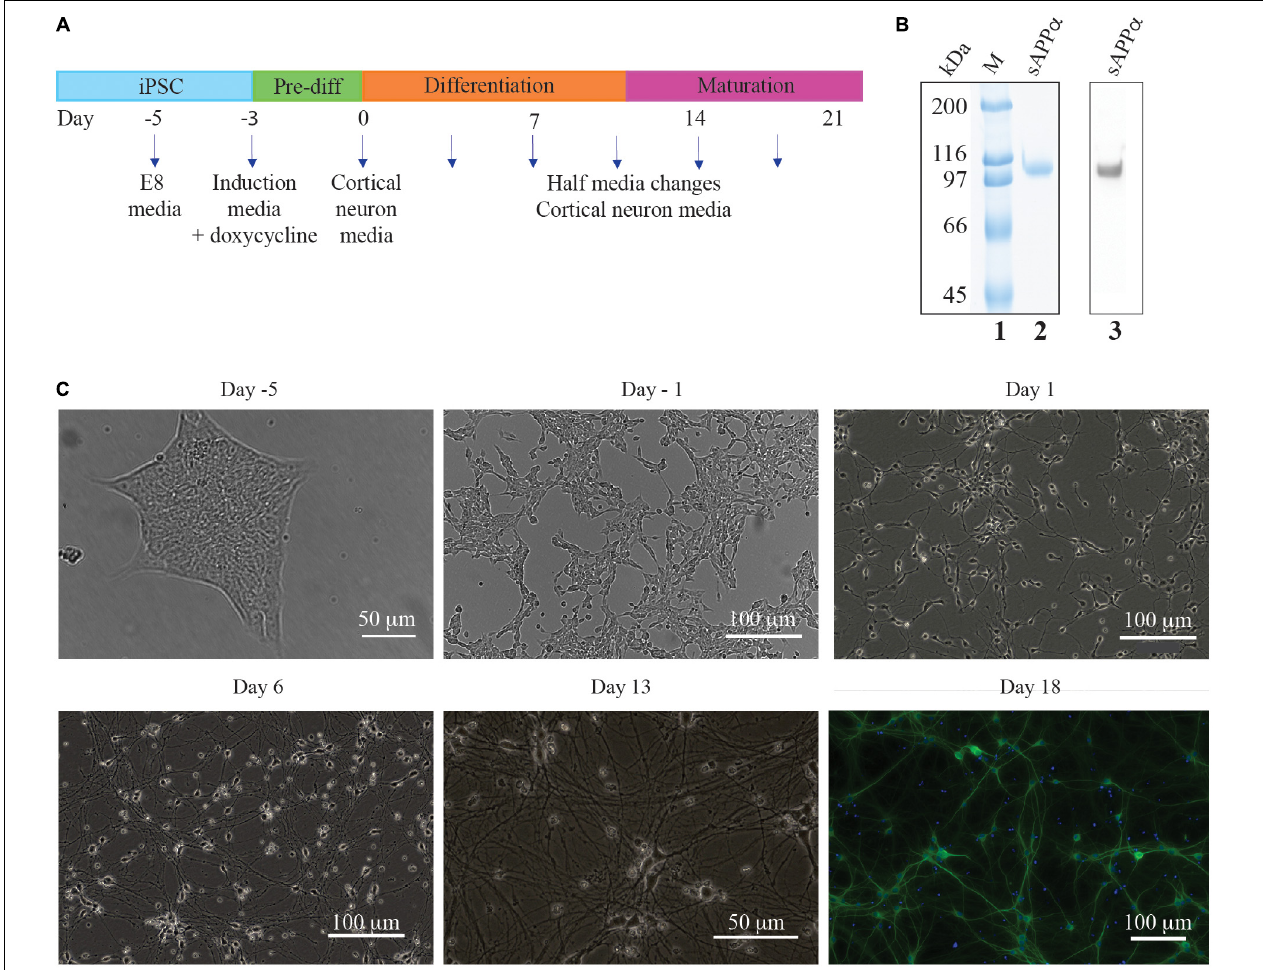
FIGURE 1 | Timeline of iPSC derived neuron generation. (A) E8 media until differentiation was required. Three day exposure (day − 3 to day 0) to induction media containing doxycycline initiated NGN2 cortical neuron transcription factor gene expression. Cells were then cultured on poly L ornithine plates in cortical